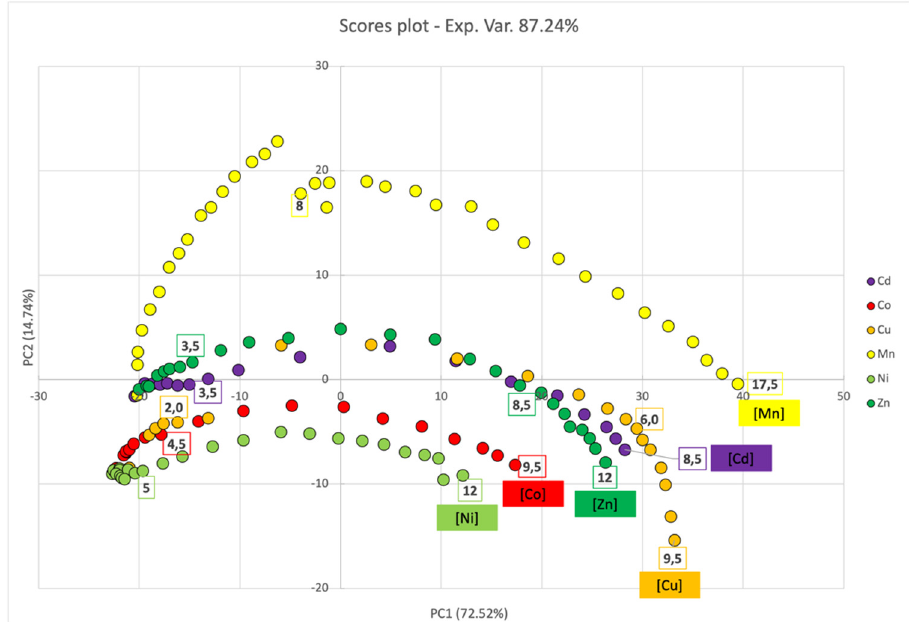
Figure 13. PCA score plot for PC1 and PC2 components upon titration of SPABs of PL 2 -AgNPs@11MUA with each metal ion.